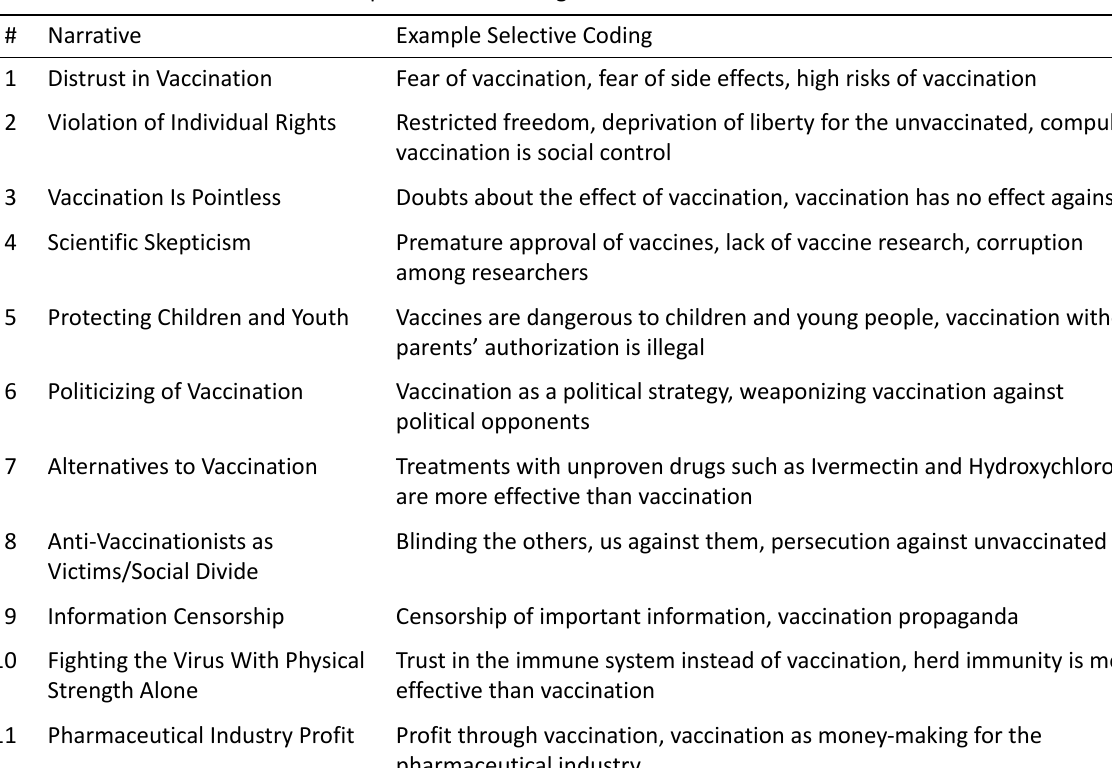
Table 3. Brazilian narratives and example selective